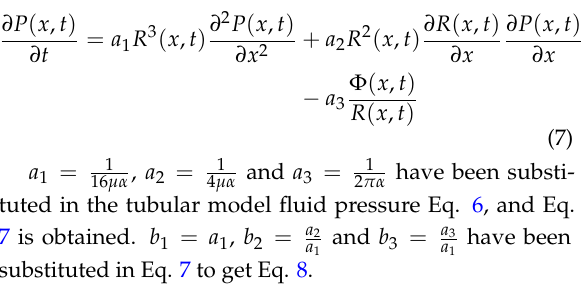
Table 1. Different Cases for obtaining CA